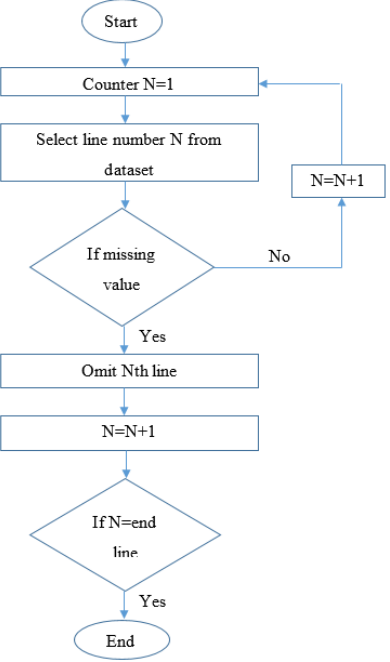
Figure 1. Missing values elimination program.